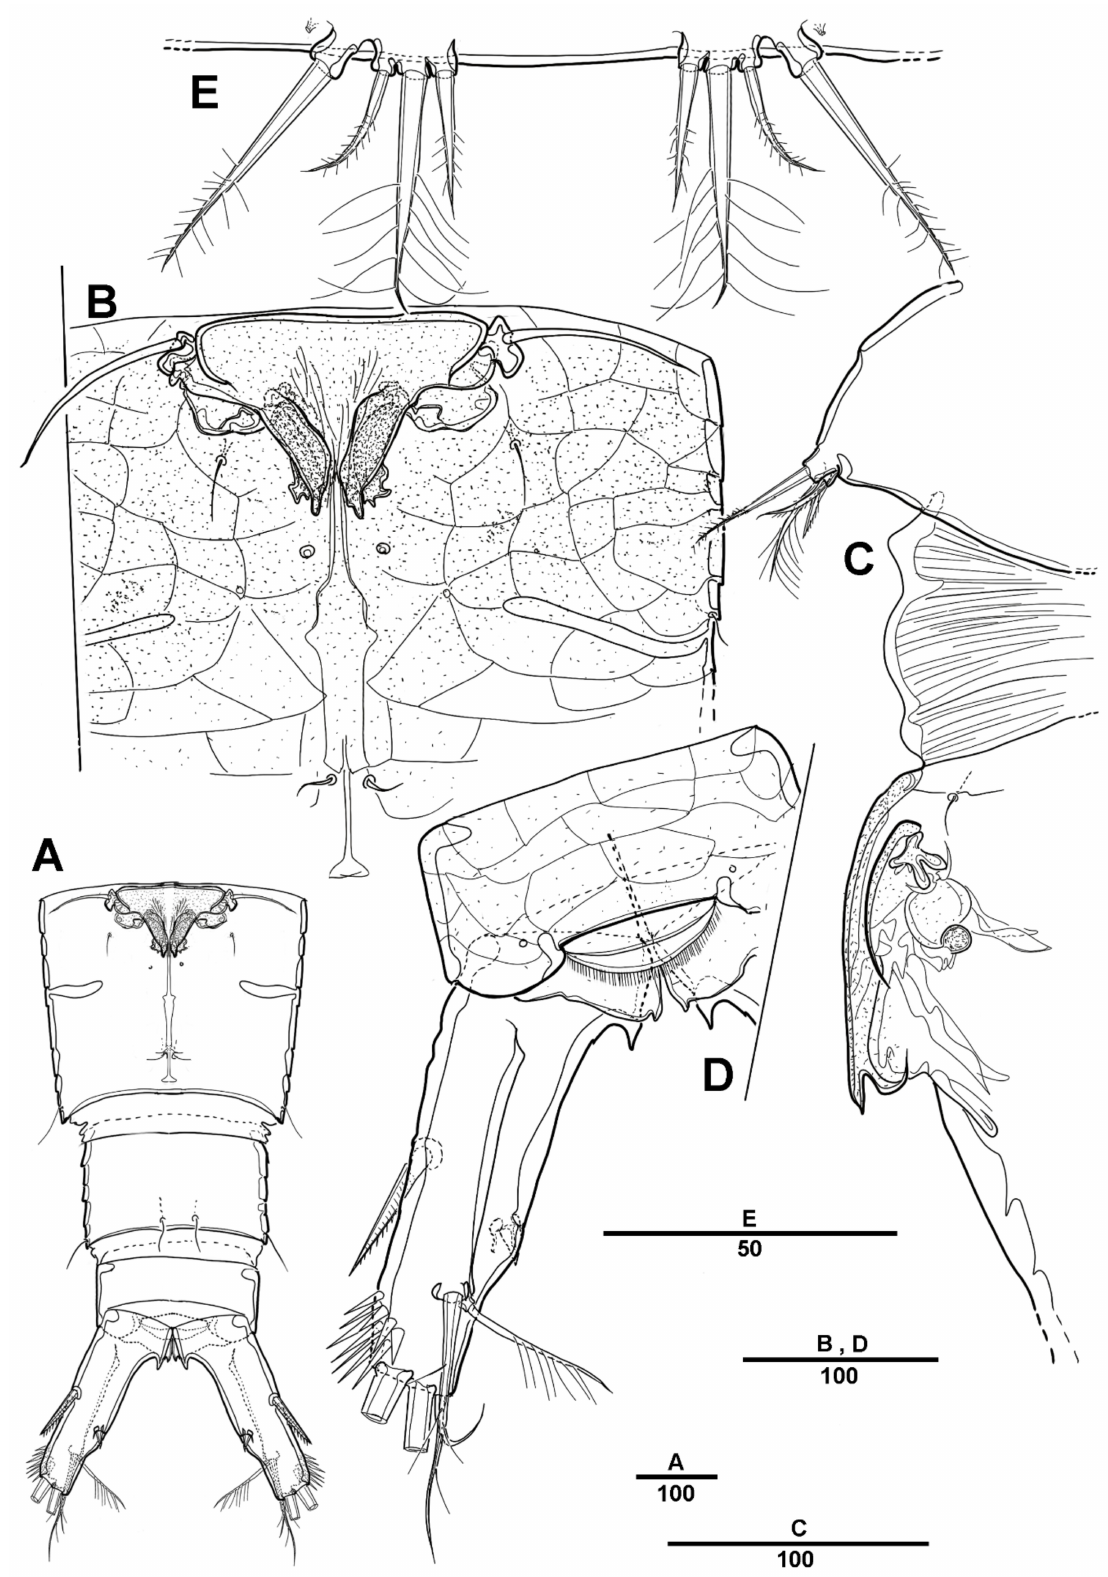
Figure 13. Scottolana wonchoeli sp. nov. holotype female: ( A ) urosome, ventral; ( B ) genital field, ventral; ( C ) P5 and genital field, lateral; ( D ) anal somite and left caudal ramus, dorsal; ( E ) P5. Scale bars in µ